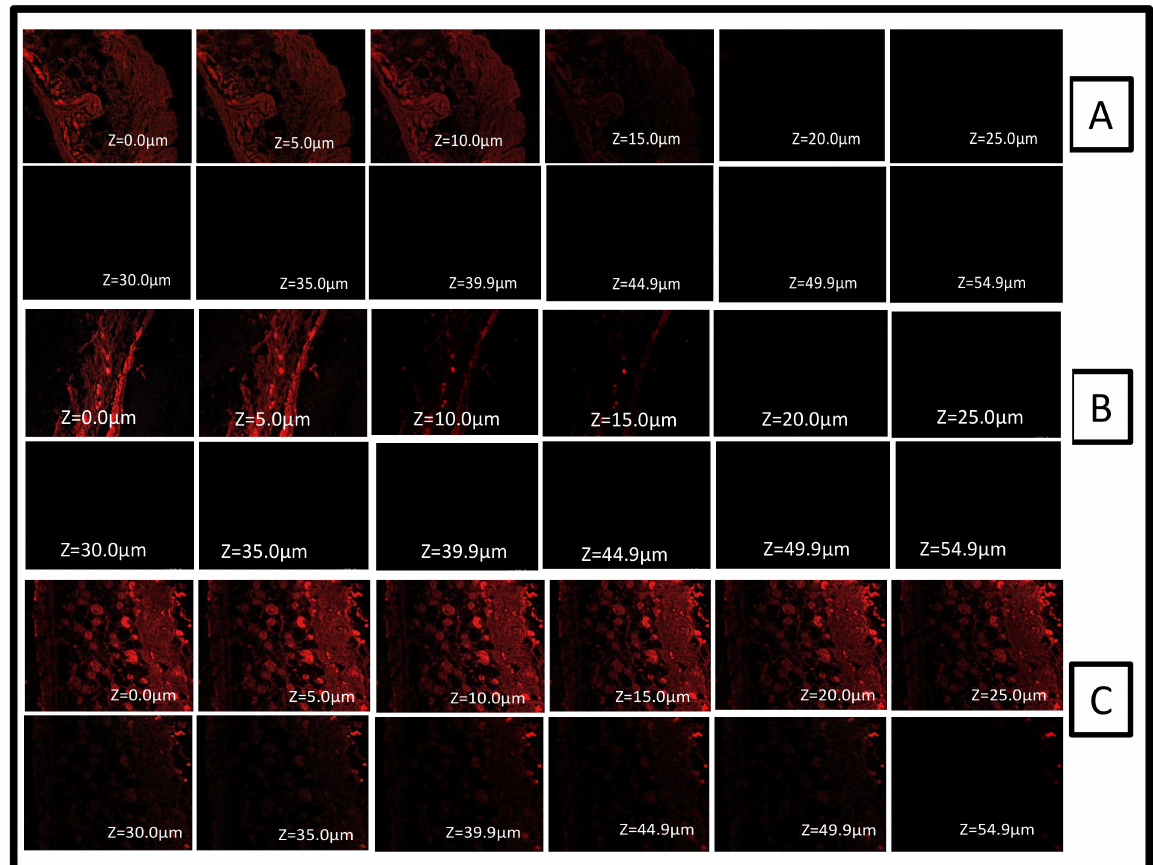
Figure 12. Confocal microscopic studies of mouse skin treated with ( A ) Rhodamine B hydroalcoholic